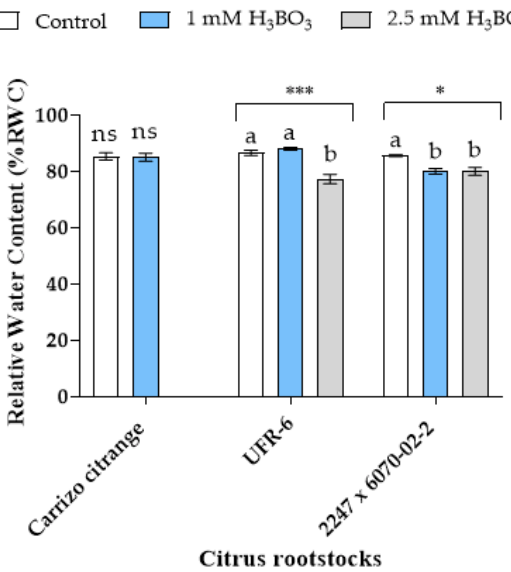
Figure 5. Relative Water Content (RWC) at day 21 of the assay in three citrus rootstocks studied (Carrizo citrange, UFR-6 and 2247 x 6070-02-2) and under three boron toxicity treatments (Control, 1 mM H 3 BO 3 , and 2.5 mM H 3 BO 3 ). Values in columns with different letters means statistical differences among treatments for each citrus rootstock by Fisher LSD test ( p < 0.05). 2.5 mM H 3 BO 3 treatment of Carrizo citrange: data not available. Significant codes: * = p < 0.05, and *** = p < 0.001; ns: non-significant differences.